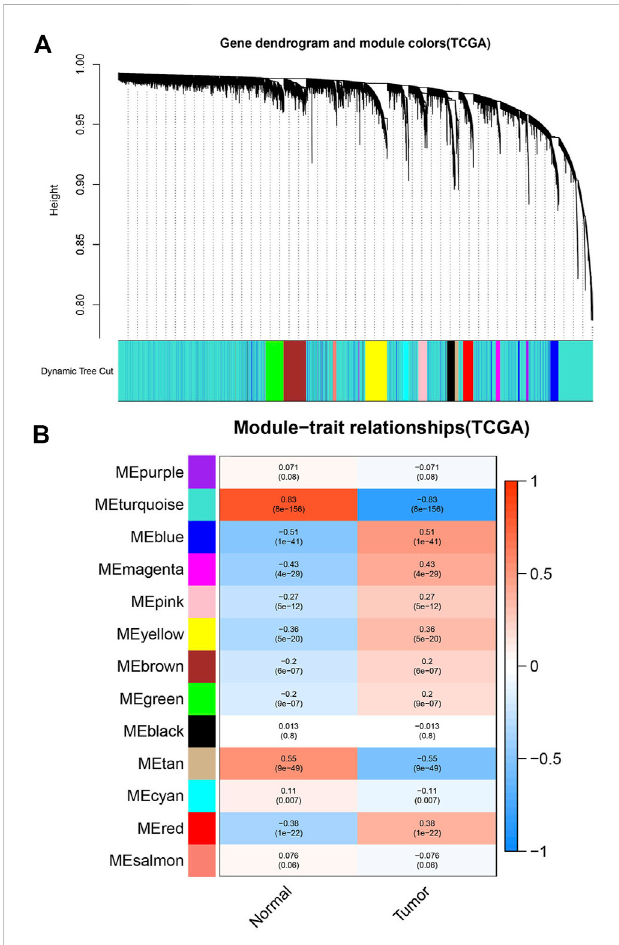
FIGURE 3 Screen the modules correlated with the clinical information from the TCGA- KIRC dataset. (A) The hierarchical clustering of genes based on the 1-TOM matrix is used to sort the clustering tree of co-expression network modules. Each module is assigned a different color. (B) Module-trait relationship in TCGA- KIRC. Each row corresponds to a color module, and each column corresponds to the tumor and normal. Each cell consists of the corresponding p -value and